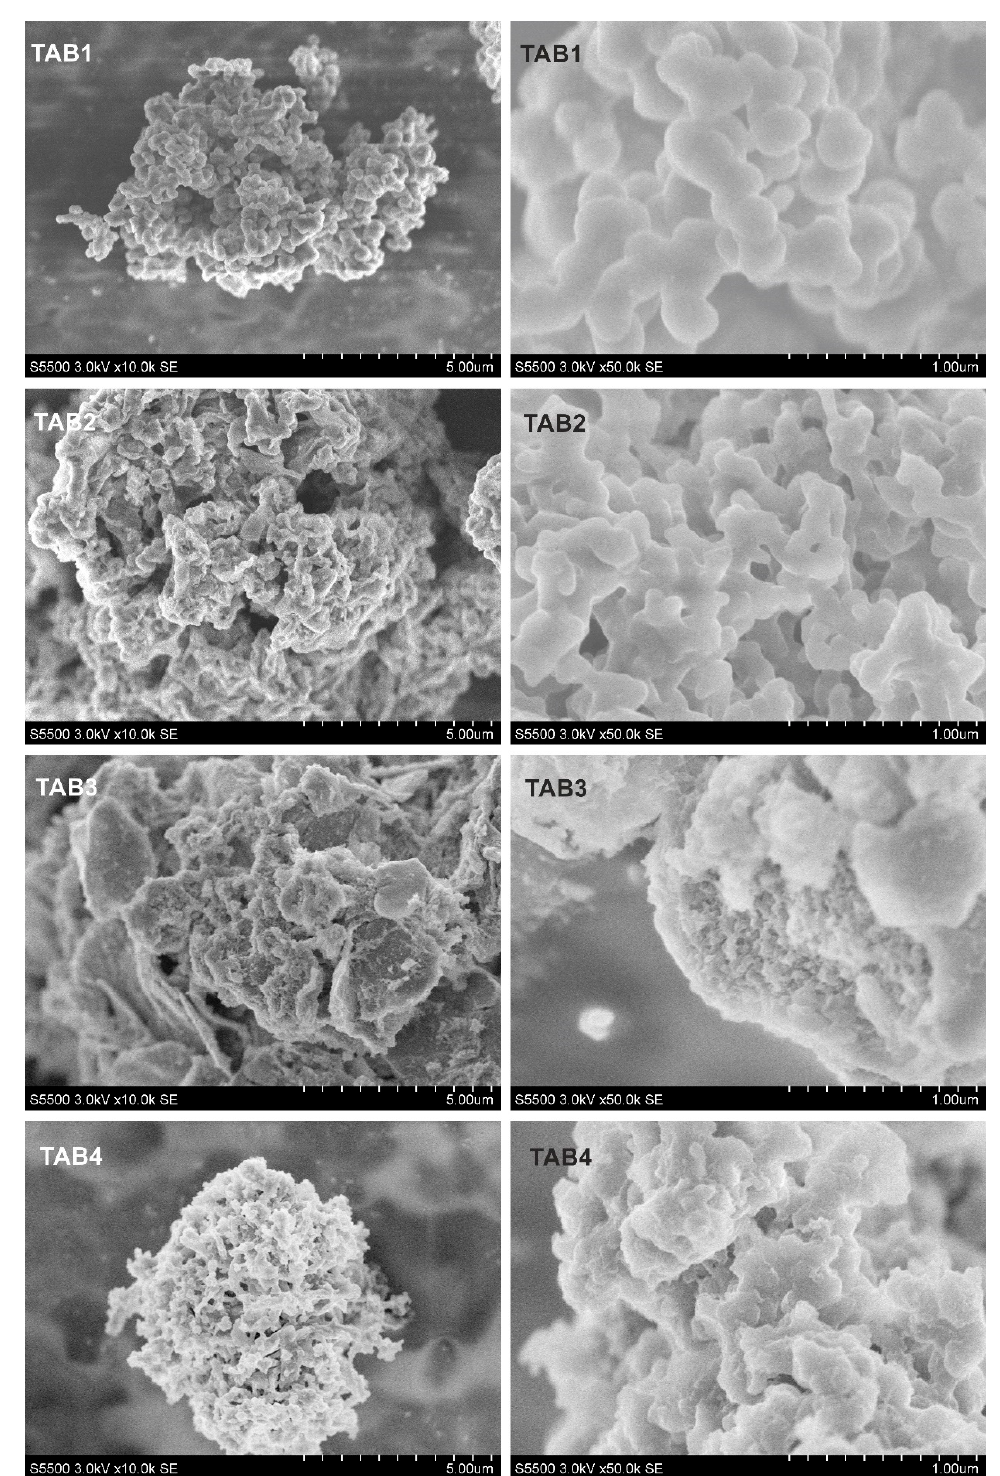
Figure 1. SEM images of TAB1–4.